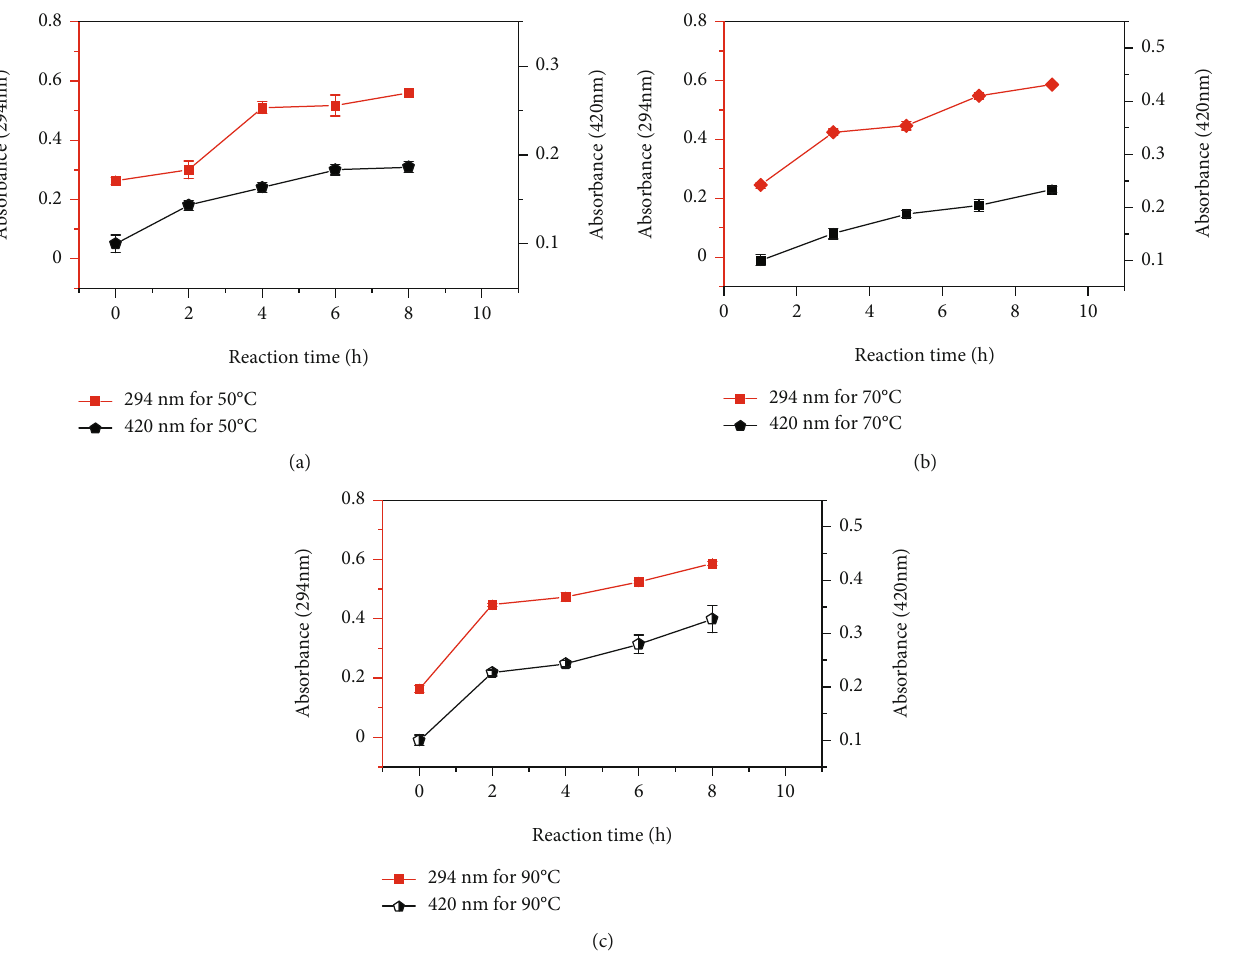
Figure 2: Changes in absorbance at 294 nm and 420nm of BSFL-Glu conjugates as a function of reaction time: (a) 50 ° C, (b) 70 ° C, and (c) 90 °